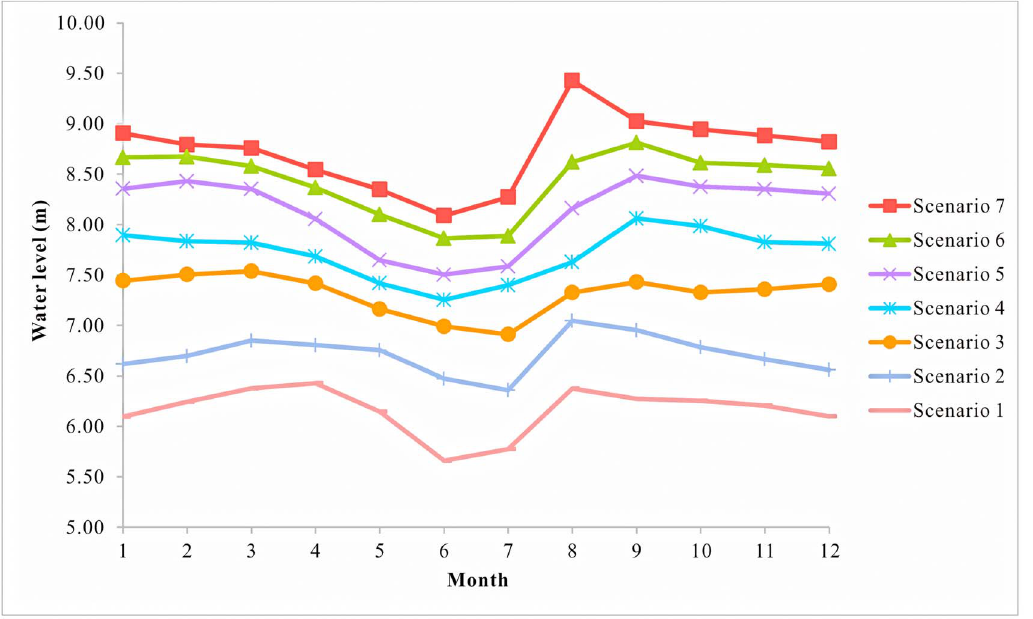
Figure 8. Water level scenarios. Seven water level scenarios were set, which correspond to water level frequency P=87.5%, P=75%, P=62.5%, P=50%, P=37.5%, P=25%,